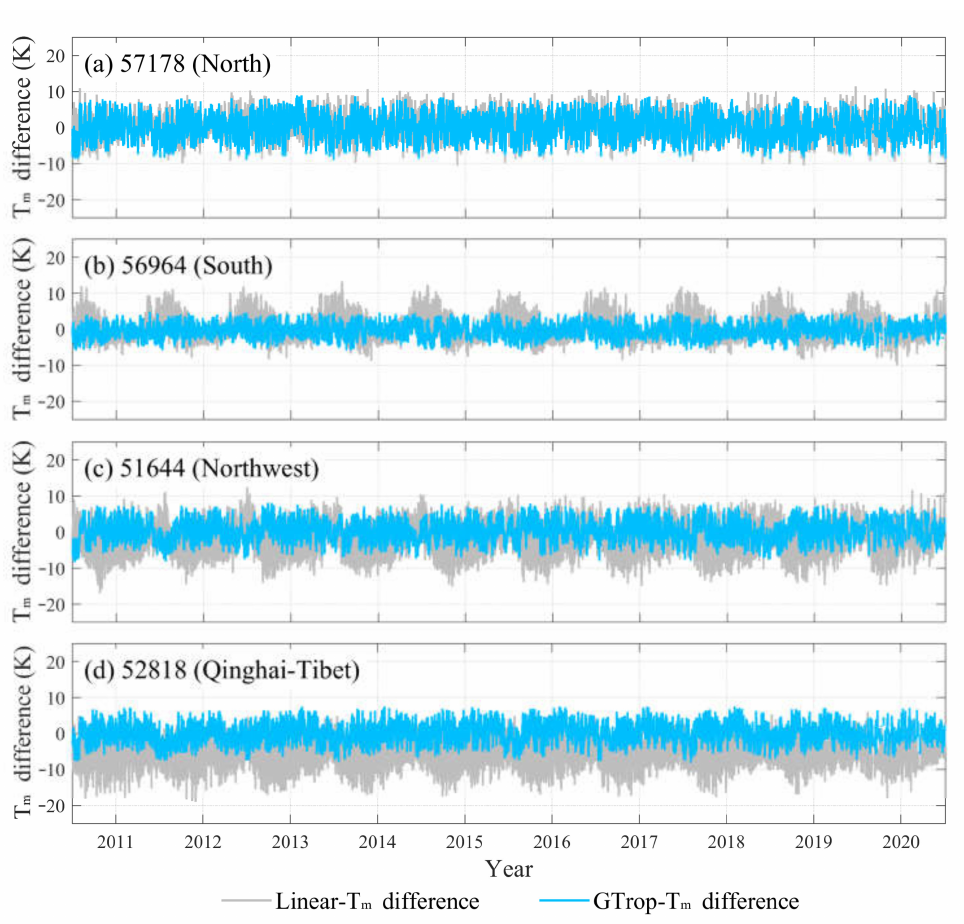
Figure 6. Comparison of T m difference between the Linear/GTrop model and four RS stations distributed across the four geographical regions of China over the period of 2011 to 2020.